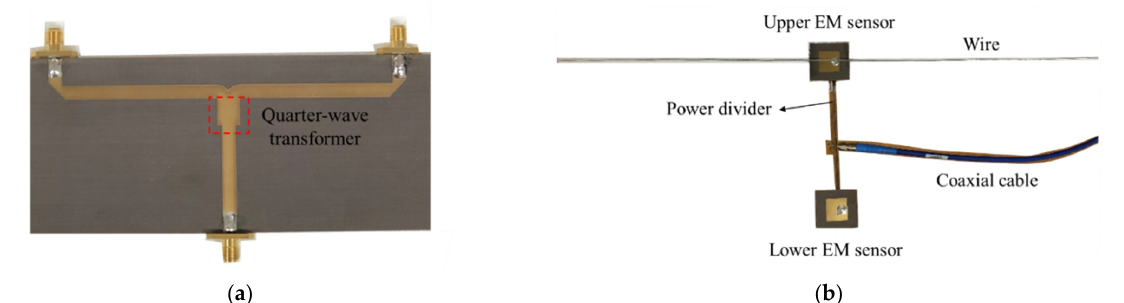
Figure 6. Structure of multi array EM sensor. ( a ) Power divider. ( b ) Dual EM sensor.